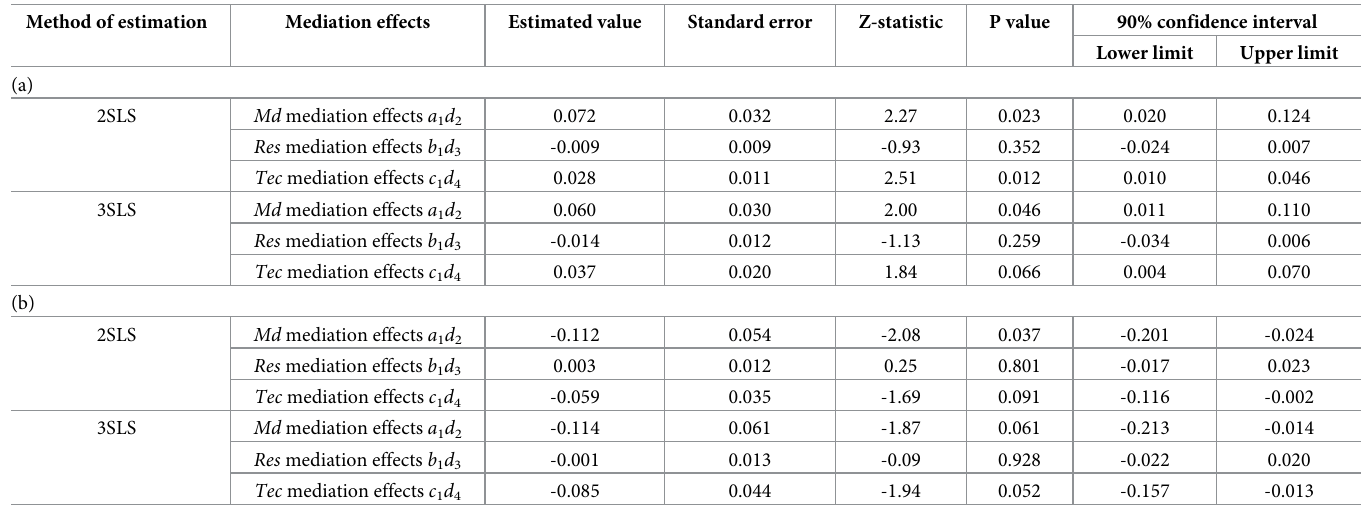
Table 10. (a): Mediation effect significance test for robustness test. (b): Mediation effect significance test for robustness test. Method of